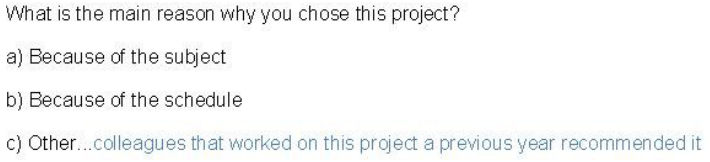
Figure 3. Student’s answer to the queston on the reason for choosing the